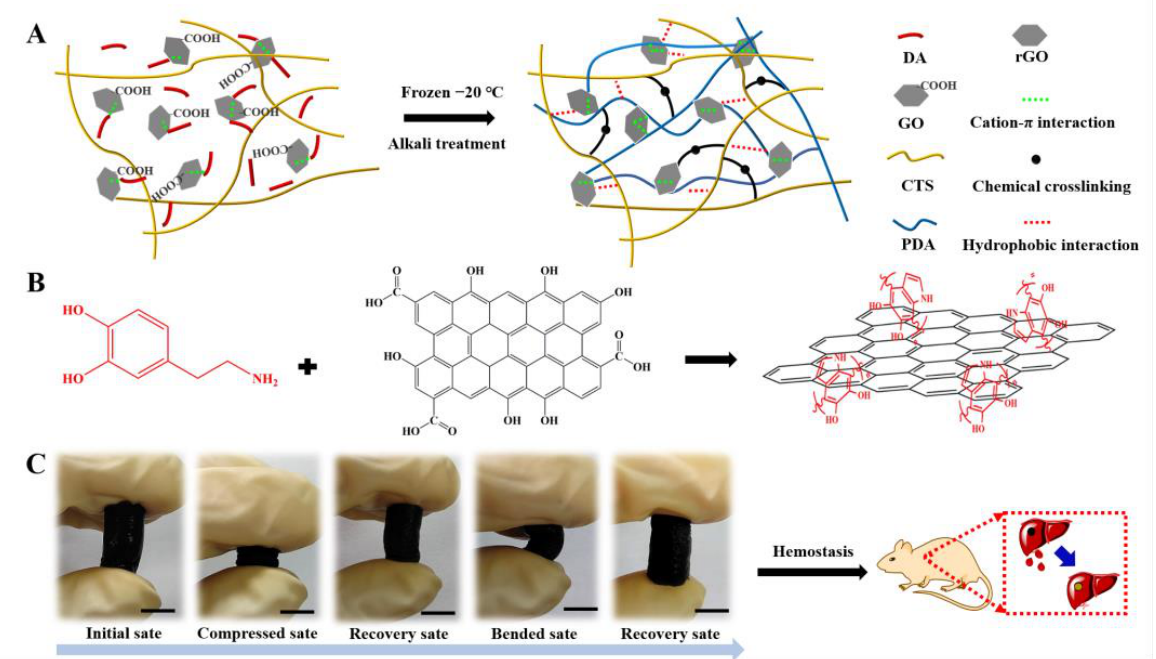
Figure 1. Schematic representation of the rGO-CTS cryogel. ( A ) Preparation of the rGO-CTS cryogel; ( B ) synthesis of the rGO; ( C ) photographs of the compression and bending resistance capability of the rGO-CTS cryogel: initial state, compressed state by squeezing out the free water, recovery state by absorbing water, bending and squeezing out part of the free water, and recovery state after absorbing